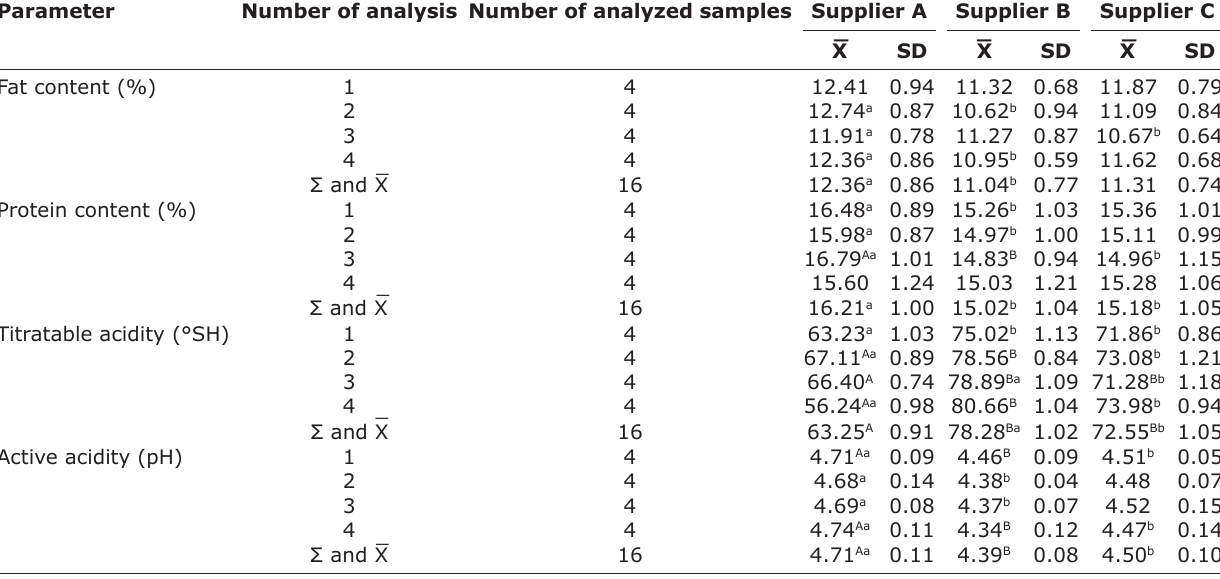
Table-5: Content of basic components and acidity of curd cheeses purchased from each supplier in consecutive analyses. Parameter